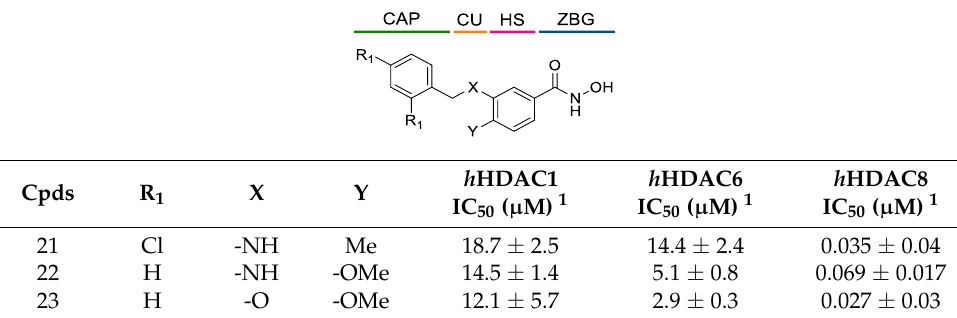
Table 3. General structure and IC 50 values of 21 , 22 , and 23 [143].